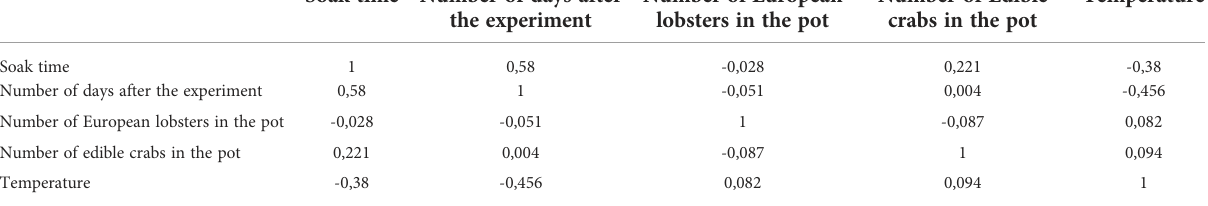
TABLE 3 Correlation among covariates. Soak time, Number of days after the experiment, Number of European lobsters in the pot, Number of Edible crabs in the pot, Temperature, n = 2395. Soak time Number of days after Number of European Number of Edible the experiment lobsters in the pot crabs in the pot